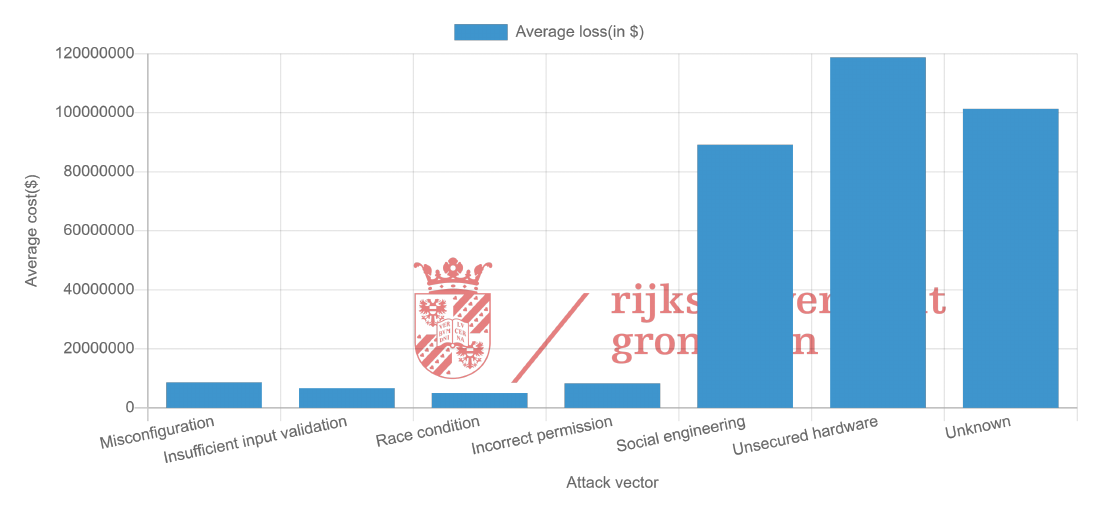
Figure 6. Average money loss per attack vector.